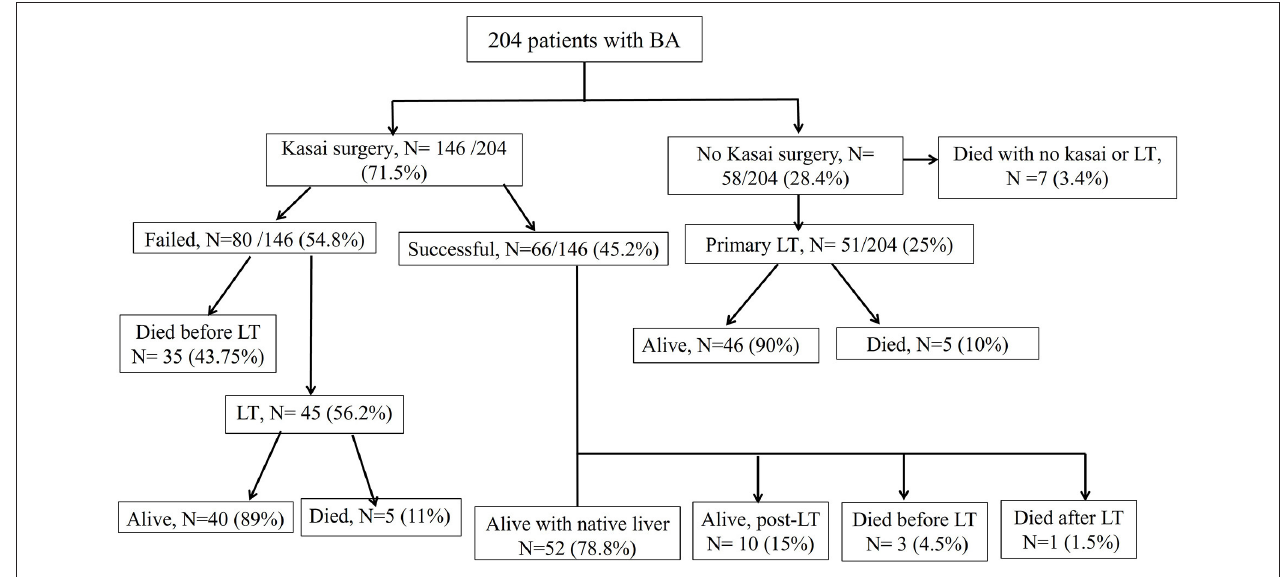
FIGURE 3 | Management and outcomes of the 204 biliary atresia cases.